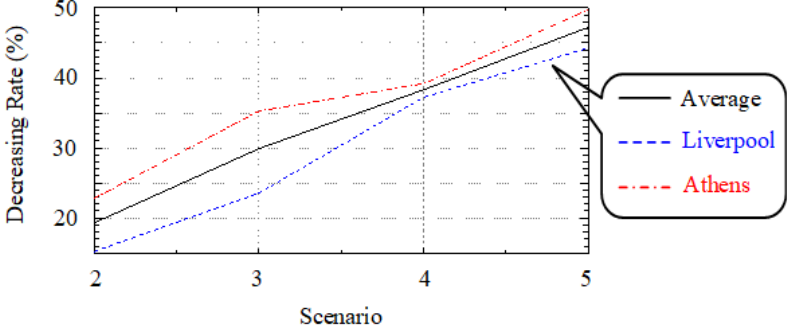
Figure 7. Decreasing rates of CO 2 equivalent production for different scenarios to scenario 1 for the average, Liverpool, and Athens cases.